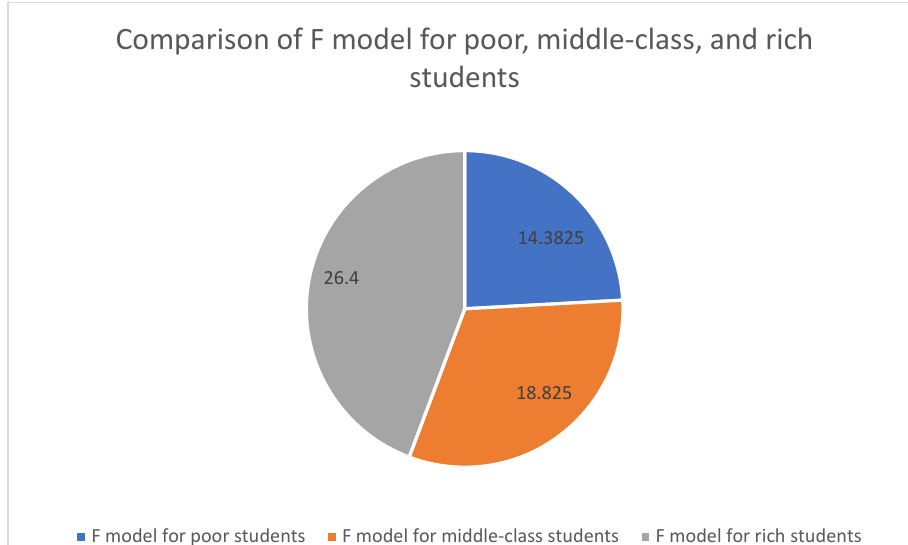
Figure 4. F model for poor, middle-class, and rich students.